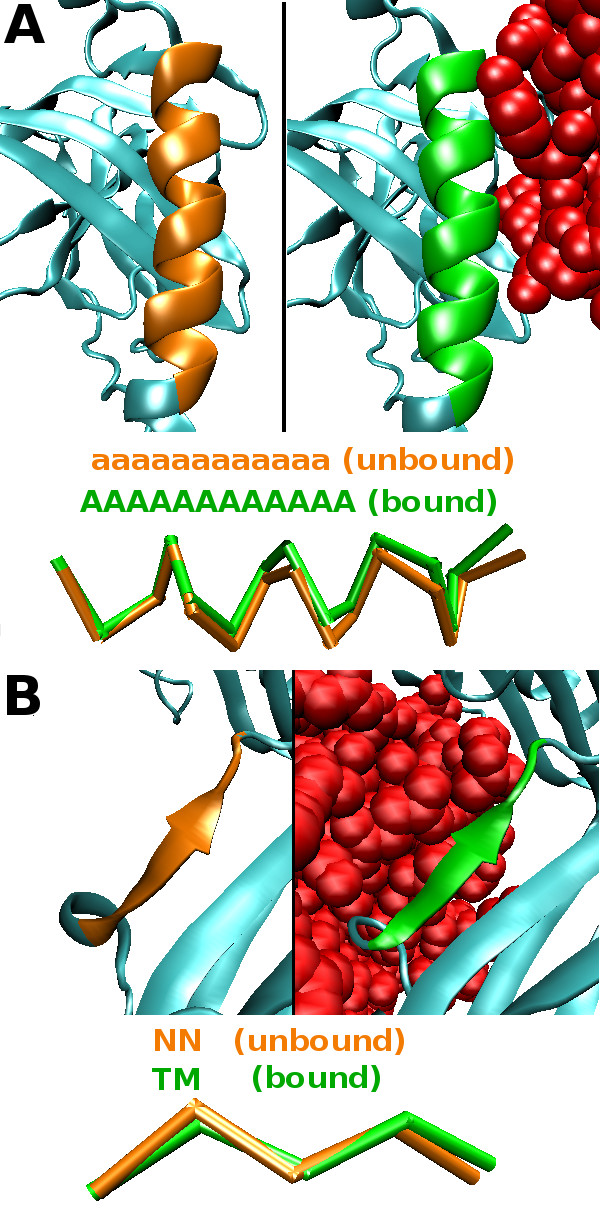
Deformation of regular secondary structures fitting the deformation tendencies. A) Example of a curved α-helix encoded by a run of [a] in the structural sequence (unbound, orange) towards a straight α-helix encoded by a run of [A] upon interaction (bound, green). B) Example of a curved β-strand encoded by a run of [N] in the structural sequence (unbound, orange) towards a straight β-strand encoded by "TM" upon interaction (bound, green).